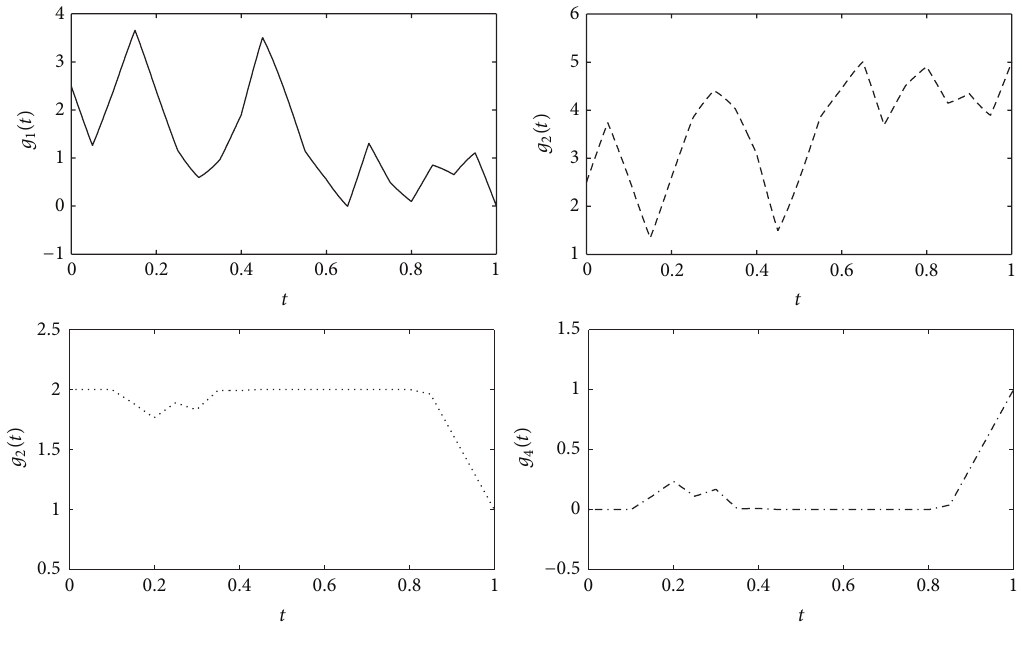
Figure 4: Constraint functions under optimal controls.